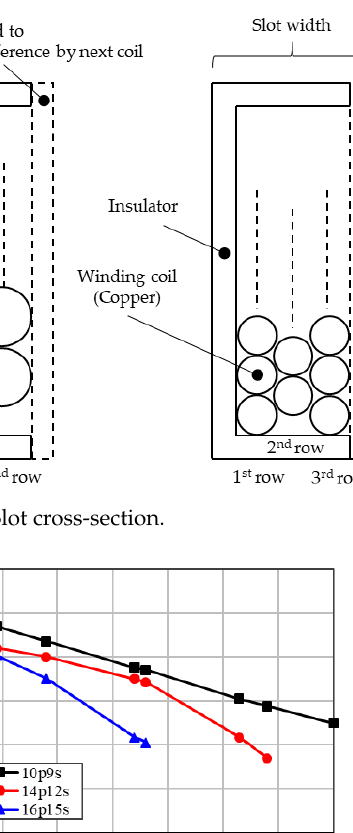
Figure 11. Number of coil turns with respect to slot width.